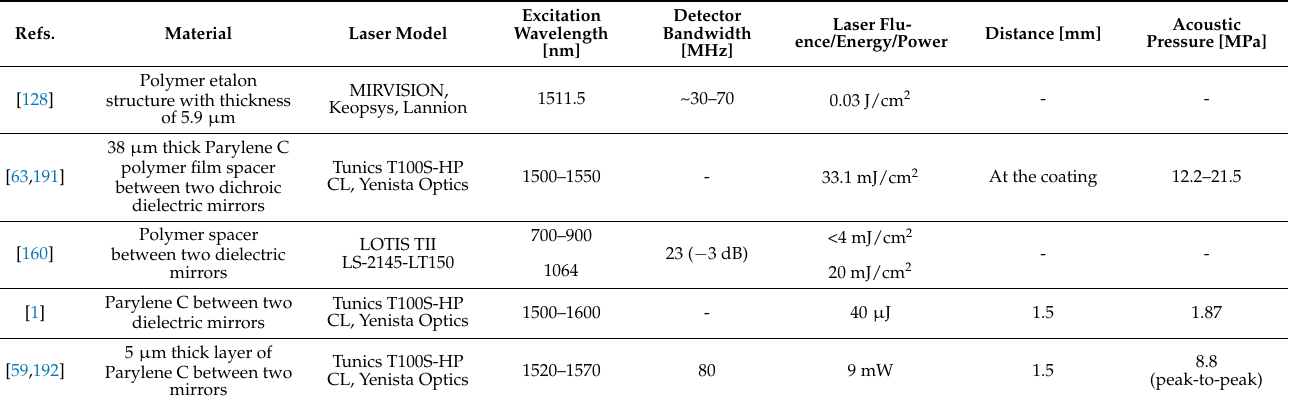
Table 3. Resulting performance of photoacoustic-based ultrasound probes using Fabry-P é rot as ultrasound